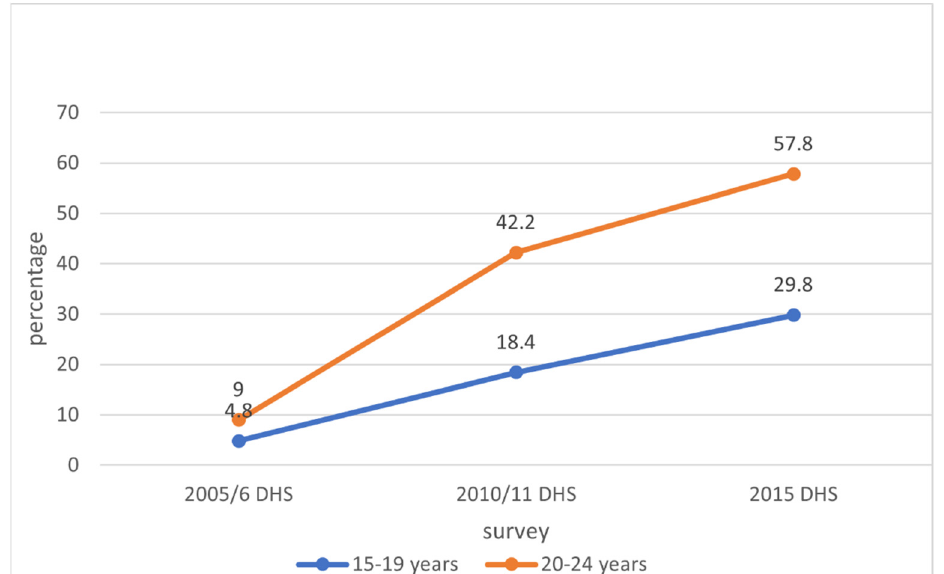
Figure 2. Trends in having an HIV test in the past one year and receiving results among adolescent girls and young women in Zimbabwe, 2005 to 2015.